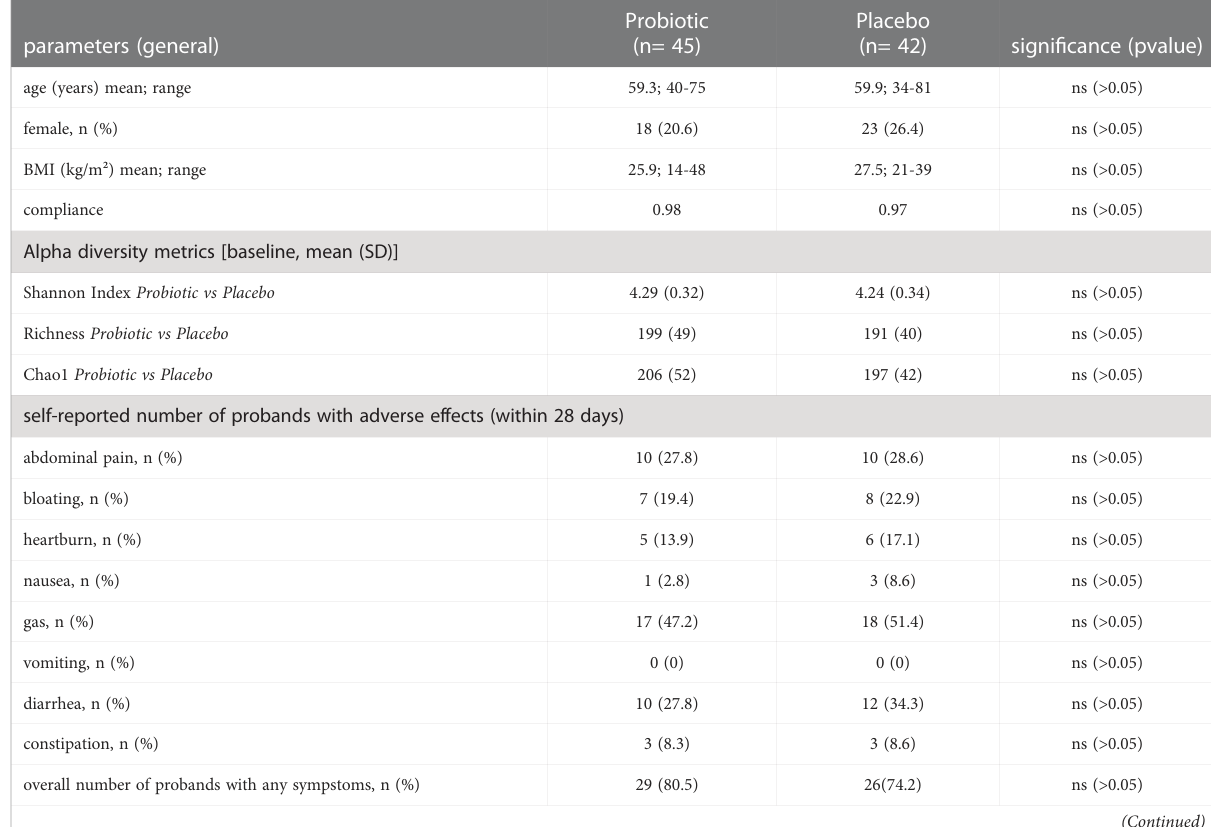
TABLE 1 Patient characteristics: Baseline characteristics and after 30 days of treatment and 28 days of